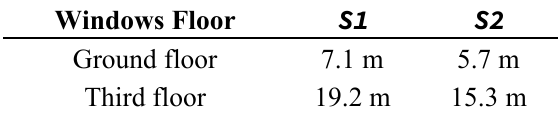
Table 1. Distances between the source positions ( S1 and S2 ) and the geometric barycentre of